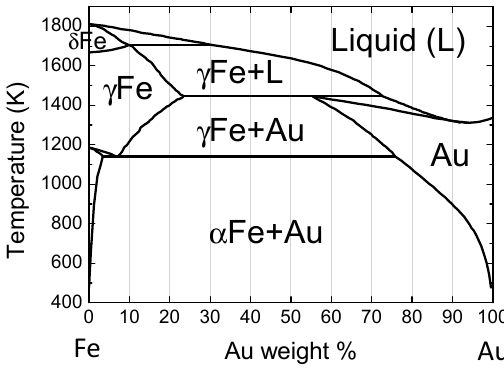
Figure 6. Phase diagram of Au-Fe system.